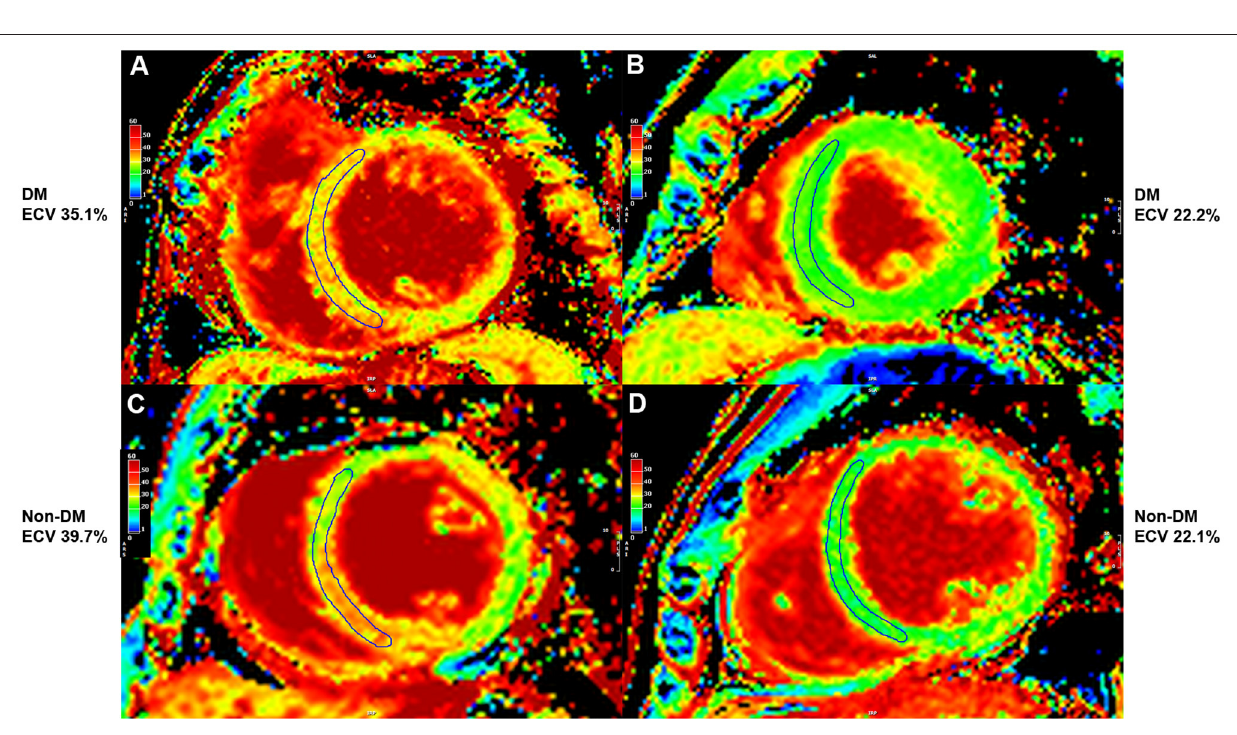
influence on CV outcomes. T2D effectuates myocardial ECM expansion via the accumulation of AGEs, with reported resulting myocardial fibrosis, systolic and diastolic dysfunction (20), vasomotor dysfunction (21), arrhythmia (22), and